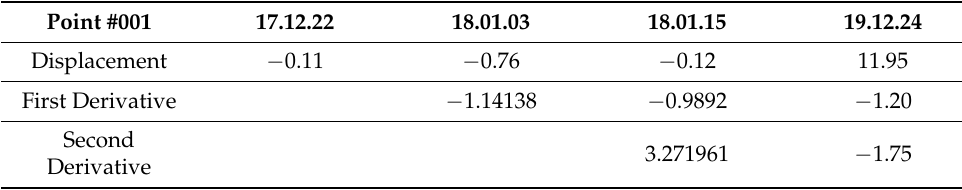
Table 3. Input and output layers for time series analysis (for a single